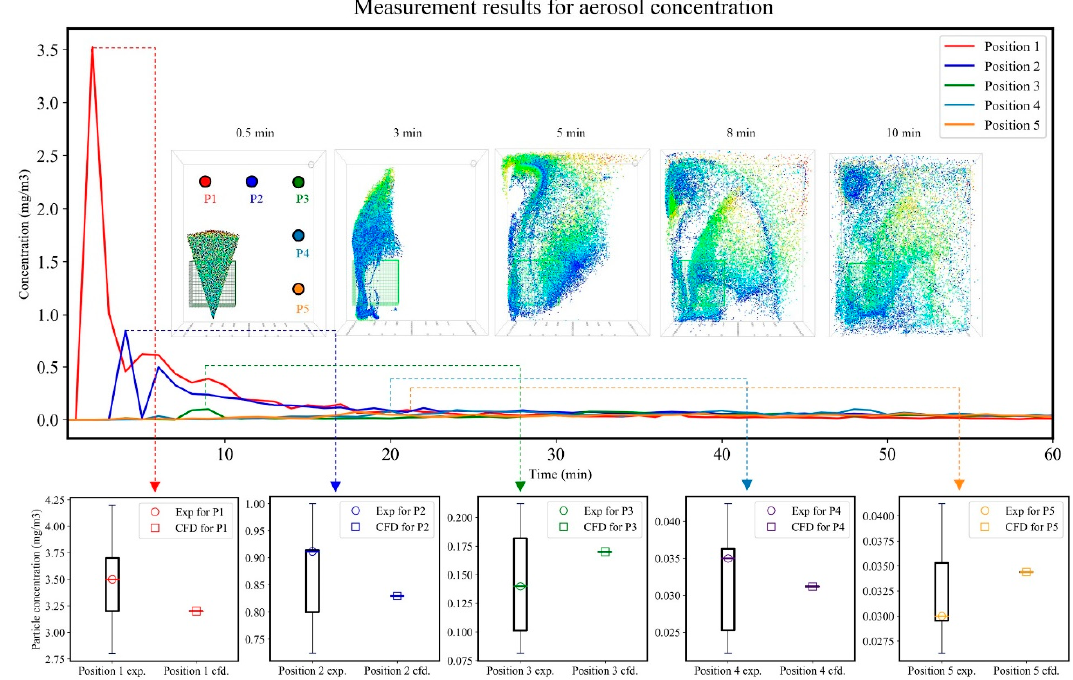
Figure 9. Comparison of measurement result with CFD results in the five measurement positions. The error bar is used due to repeated experiments. The circle is the average of the measurement results, which is the peak concentration. The CFD results according to the measurement position are similar to the measurement results.